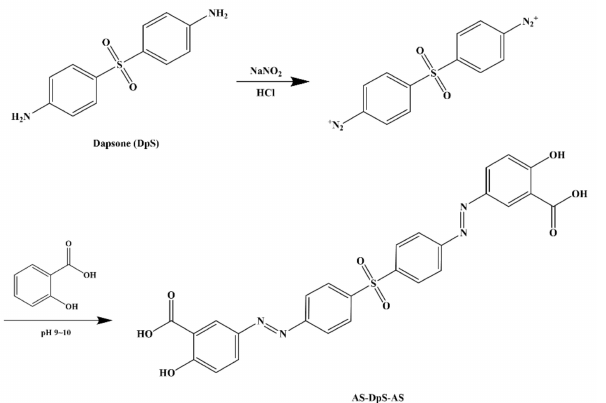
Figure 1. Synthesis of 1,1 (cid:48) -Sulfonylbis[4-(3-carboxy-4-hydroxyphenyl)azo]benzene